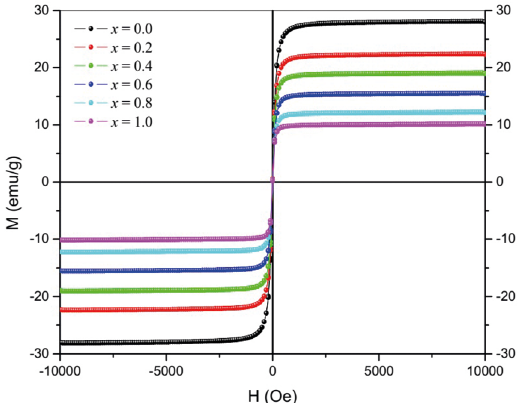
Al Fe O garnet samples. 3 x (5- x ) 12